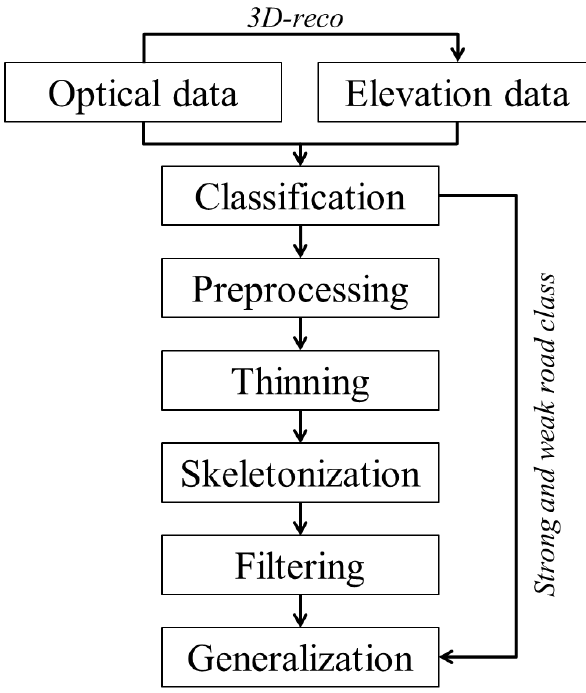
Figure 1: Filtering polylines. Top: assessing segments and junc- tions, bottom: updating topology. See text for more details.